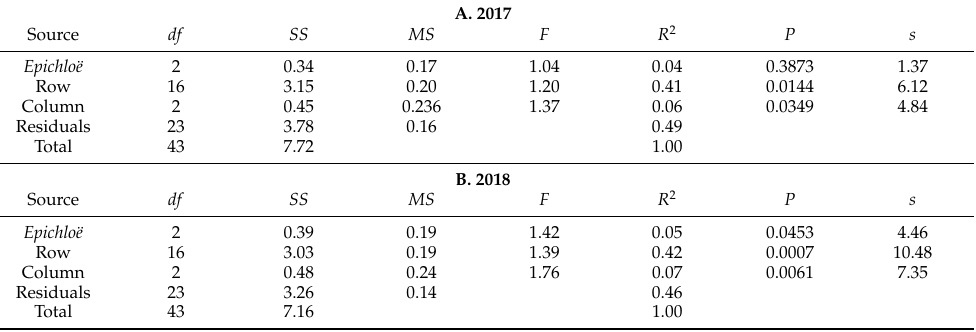
Table 3. PERMANOVA analyses by year. The row and column sources of variance refer to the physical layout of the experiment, see Figure 1. df = degrees of freedom, SS = sum of squares, MS = mean squares, F = pseudo- F statistic, P = p -value; s denotes the Shannon Information ( p ) ); see Section 2.5. The Epichloë treatment was important in 2018 but Transformation ( s = − log 2 not